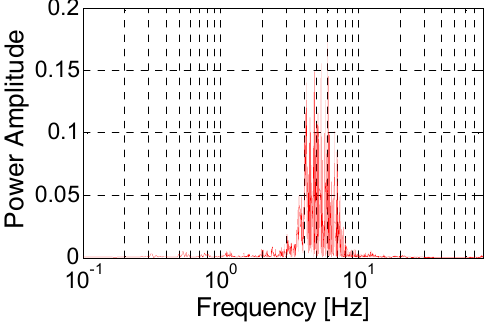
Figure 2. Power spectrum of acceleration data from 2011 Honshu earthquake.